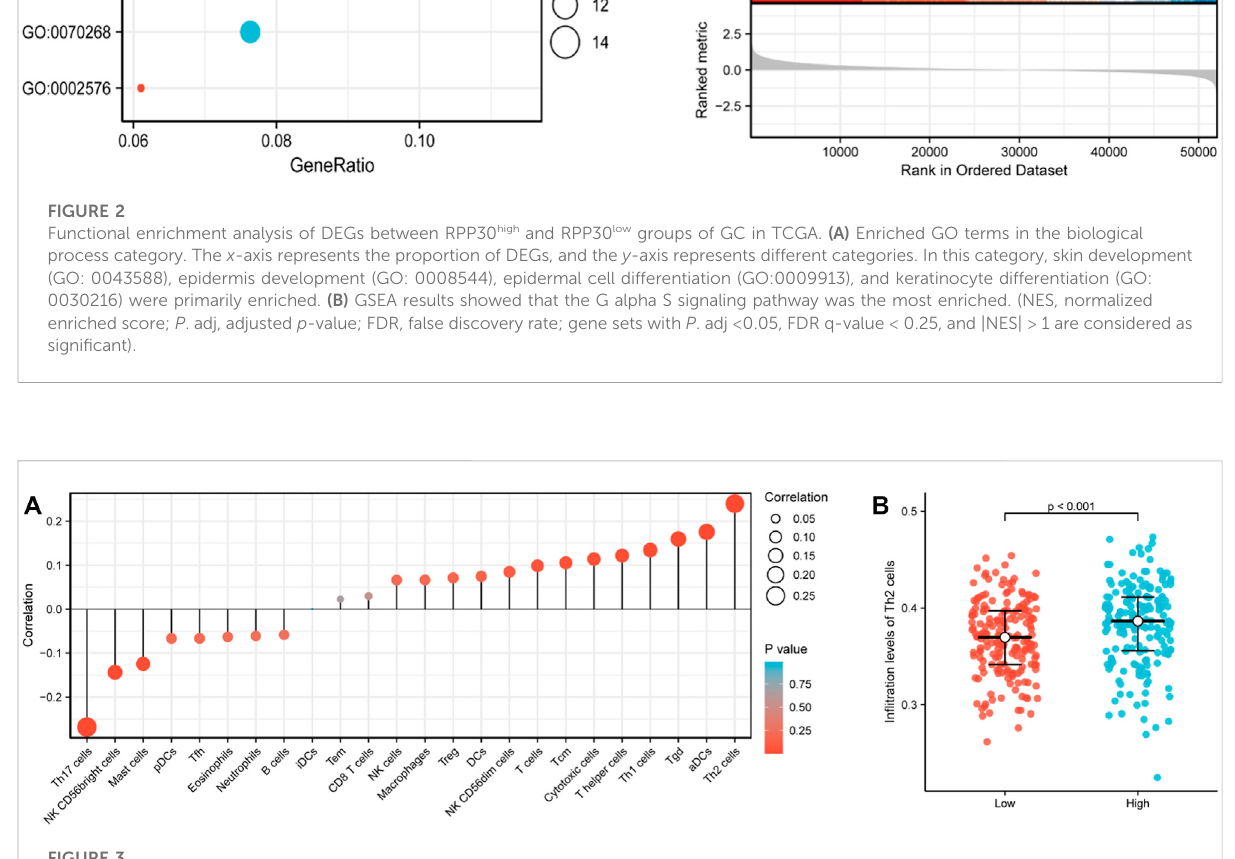
stage ( p < 0.001), primary therapy outcome ( p < 0.001),